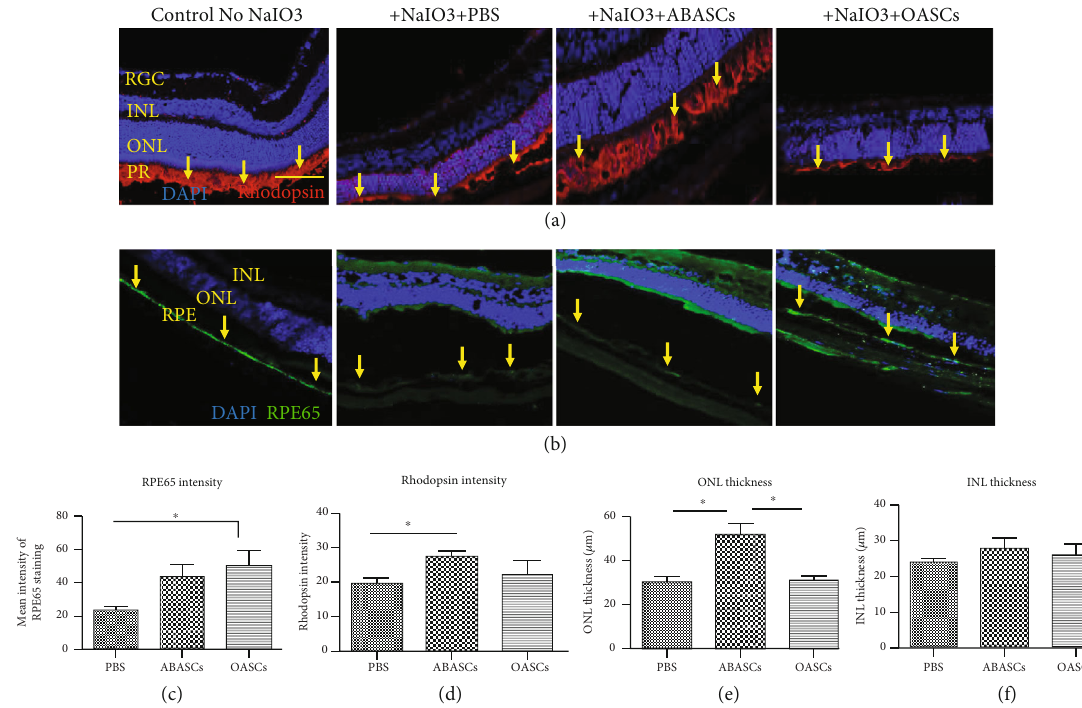
Figure 5: Retinal layers 21 days post transplantation of ABASCs and OASCs in the NaIO3 mice model. (a) Immunohistochemistry pictures of mice retinas for ONL quanti fi cation and rhodopsin intensity by DAPI and rhodopsin staining in ABASCs and OASCs transplanted mice versus controls. Yellow arrows indicate the PR layer. (b) Immunohistochemistry pictures of the mice RPE layer after RPE65 and DAPI staining in ABASC and OASC transplanted mice versus controls. Yellow arrows indicate the RPE layer. (c) Graphic summary of RPE65 intensity evident by RPE65. (d) Graphic summary of rhodopsin intensity evident by rhodopsin staining. (e) Graphic summary of ONL thickness evident by DAPI staining. (f) Graphic summary of INL thickness evident by DAPI staining. ONL: outer nuclear layer; INL: inner nuclear layer; RGC: retinal ganglion layer; PR: photoreceptor; RPE: retinal pigment epithelium. Bar = 100 μ m . For each group of mice, n = 5 . Data are represented as mean ± SEM